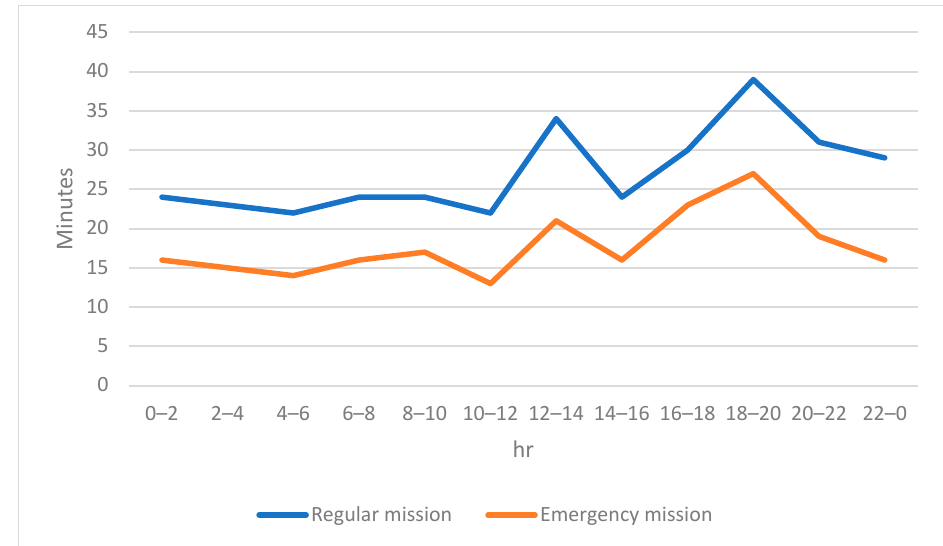
Figure 9. Extra time spent on charging within a day.